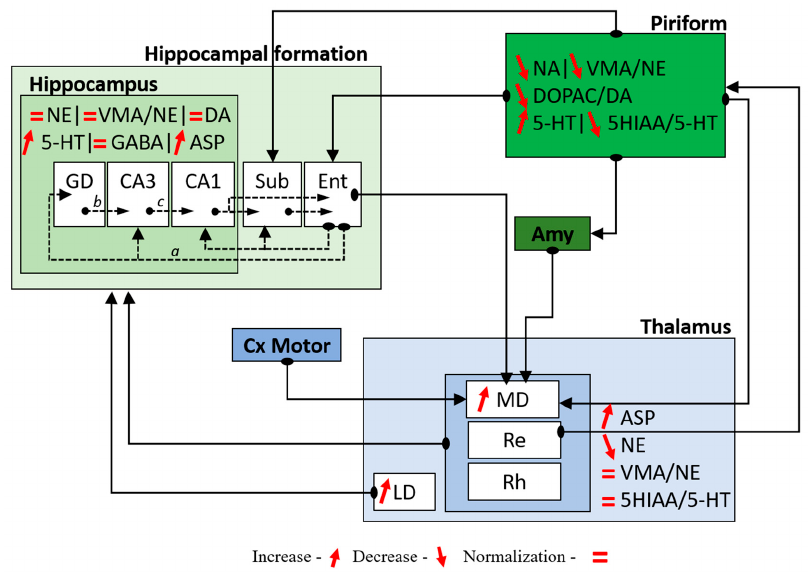
Figure 5. Schematic representation of the acute changes in the hippocampus, piriform cortex, and thalamus based on c-Fos and HPLC-measured changes. Entorhinal cortex (Ent) is the main entrance of hippocampus projecting directly into DG and CA3 via the perforant pathway (a), but projects also to CA1 and the subiculum (Sub). Mossy fibers project from DG to CA3 (b) and the Schaffer collaterals connect CA3 to CA1 (c). CA1 sends efferent projections to the subiculum and the entorhinal cortex. The subiculum sends also efferent projections into entorhinal cortex. The piriform cortex sends projections to the subiculum, entorhinal cortex, amygdala and MD thalamic nucleus, and receives efferent projections coming from the thalamic reuniens nucleus. Finally, the MD also receives afferences coming from entorhinal cortex, amygdala, and motor cortex. Midline thalamic nuclei (MD, Re and Rh) and the LD nucleus send projections to the hippocampal formation. At the bottom of the figure, the comparisons indicated are as follows: increase and decrease occurring in CRS-treated rats compared to CT. Normalization means values identical in CRS and CT rats and most often represent decreases that occur in CRS compared to DZP Figure S2: Hippocampal level of amino acids (nmol/mg) and mono amines (ng/g); Figure S3: Thalamic level of amino acids (nmol/mg) and mono amines (ng/g); Figure S4: Level of amino acids (nmol/mg) and mono amines